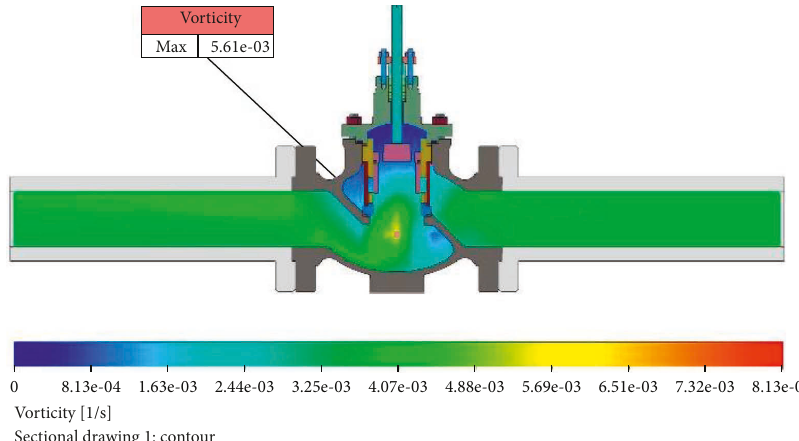
Figure 28: Mach number cloud map for 40% opening.